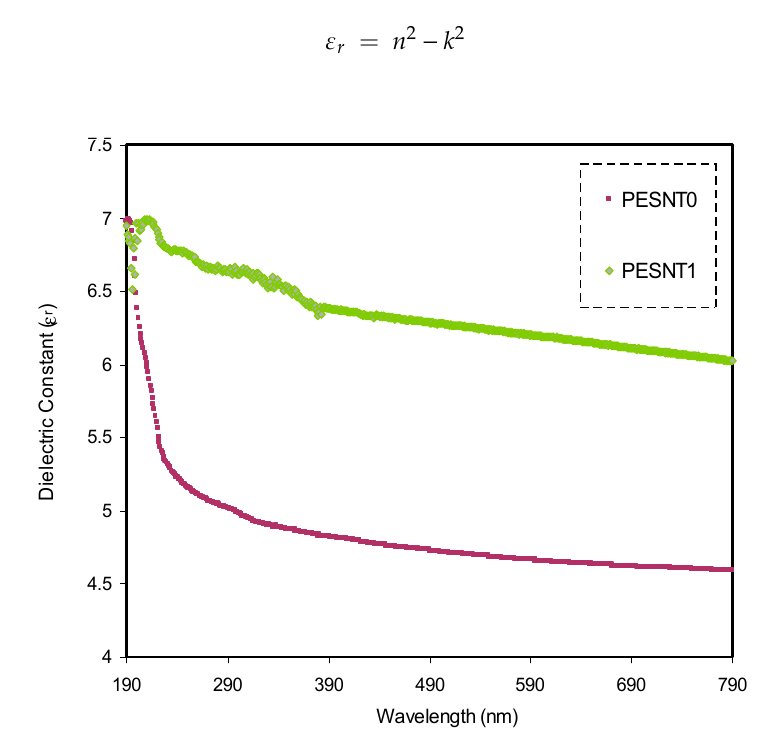
Figure 5. Optical dielectric loss ( ε r ) for pure PEO (PESNT0) and PEO:SnTiO 3 (PESNT1) samples.